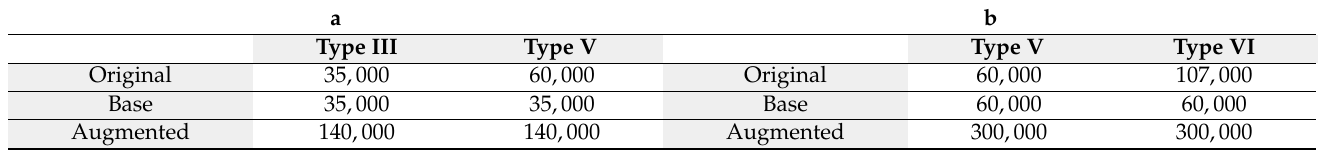
Table 3. Nodule datasetfor the ( a ) first and ( b ) second classifiers of the